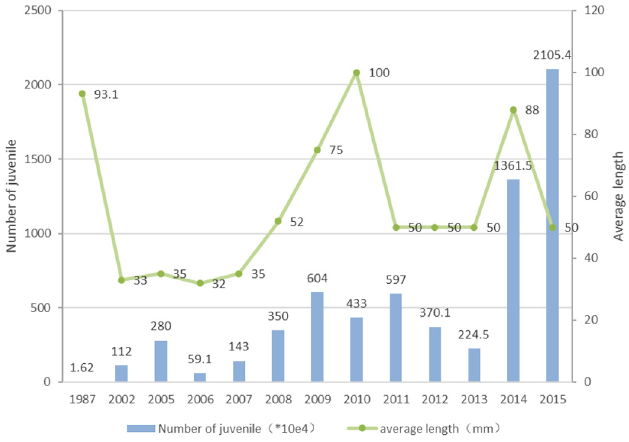
Fig. 4. Release of the large yellow croaker juvenile from 1987 to 2015 in Guanjingyang,